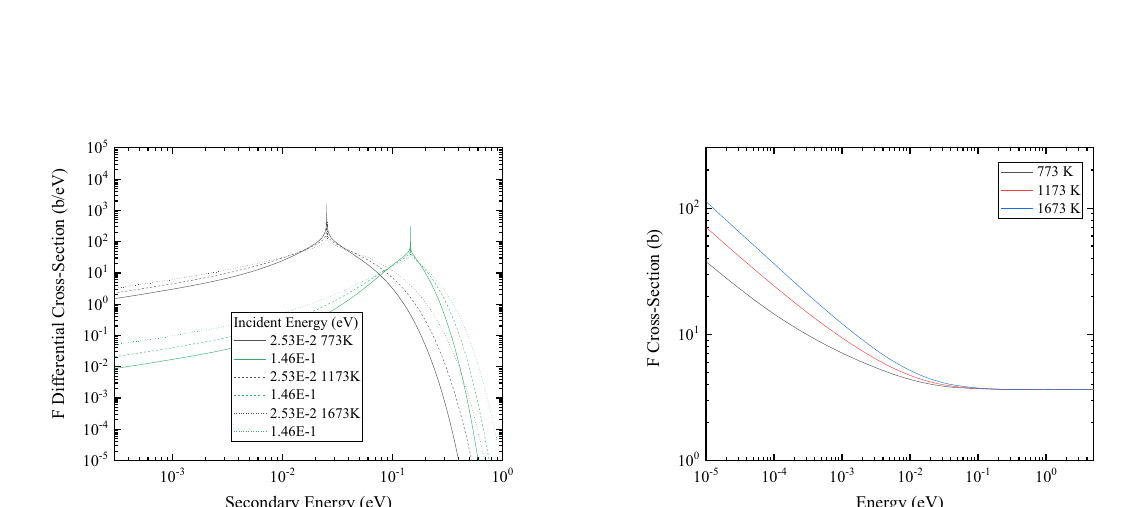
Figure 6. Secondary distribution (left, for various incident energies) and total scattering cross- section (right) for F in FLiBe at 773 K, 1173 K, and 1673 K.